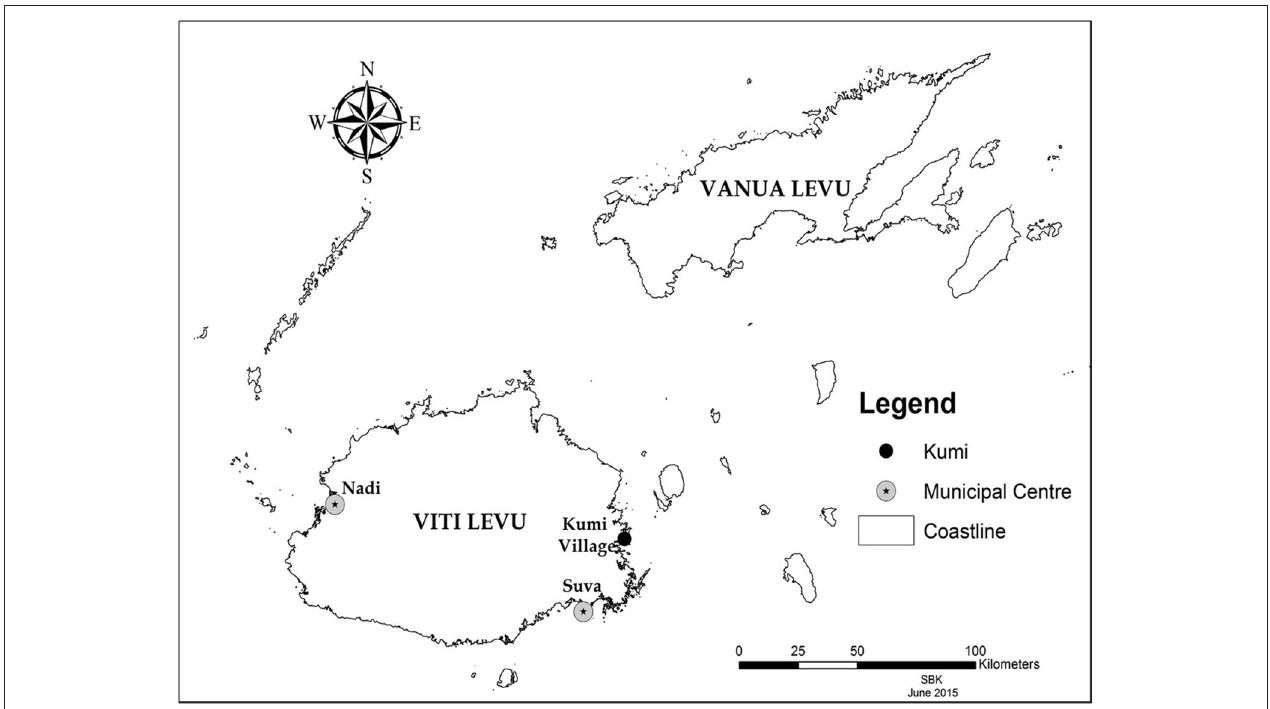
FIGURE 1 | Location of the case study site, Kumi village, on the eastern coast of Viti Levu